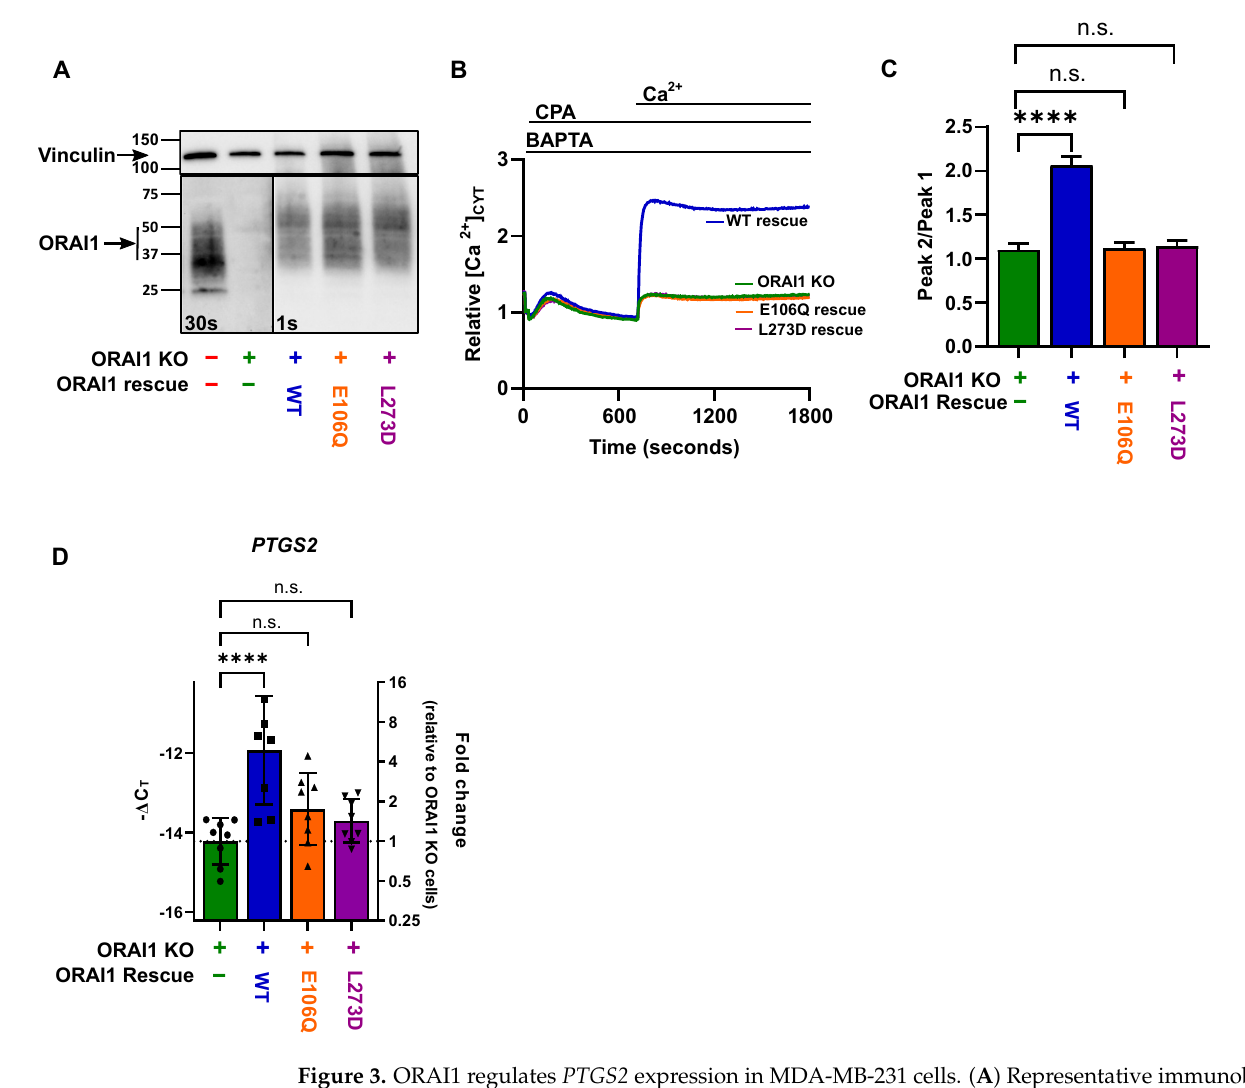
Figure 3. ORAI1 regulates PTGS2 expression in MDA-MB-231 cells. ( A ) Representative immunoblot showing endogenous ORAI1 expression in MDA-MB-231 parental cells; ORAI1 knockout cells; and ORAI1 WT, ORAI1 E106Q, and ORAI1 L273D overexpression in MDA-MB-231 ORAI1 knockout cells. ( B ) Representative traces of store-operated calcium entry in MDA-MB-231 parental cells (red), ORAI1 knockout cells (green), ORAI1 WT (blue), ORAI1 E106Q (orange), and ORAI1 L273D (purple) rescue cells. ( C ) Bar graphs showing peak2/peak1 (SOCE) from three independent experiments and representing mean ± SD (n.s., not significant ( p ≥ 0.05); **** p < 0.0001, one-way ANOVA with Dunnett’s post-hoc). ( D ) Bar graph showing −Δ C T (left axis) and PTGS2 mRNA fold change (right axis) of eight independent experiments and representing mean ± SD (n.s., not significant ( p ≥ 0.05); **** p < 0.0001, one-way ANOVA with Dunnett’s post-hoc performed on −Δ C T values).